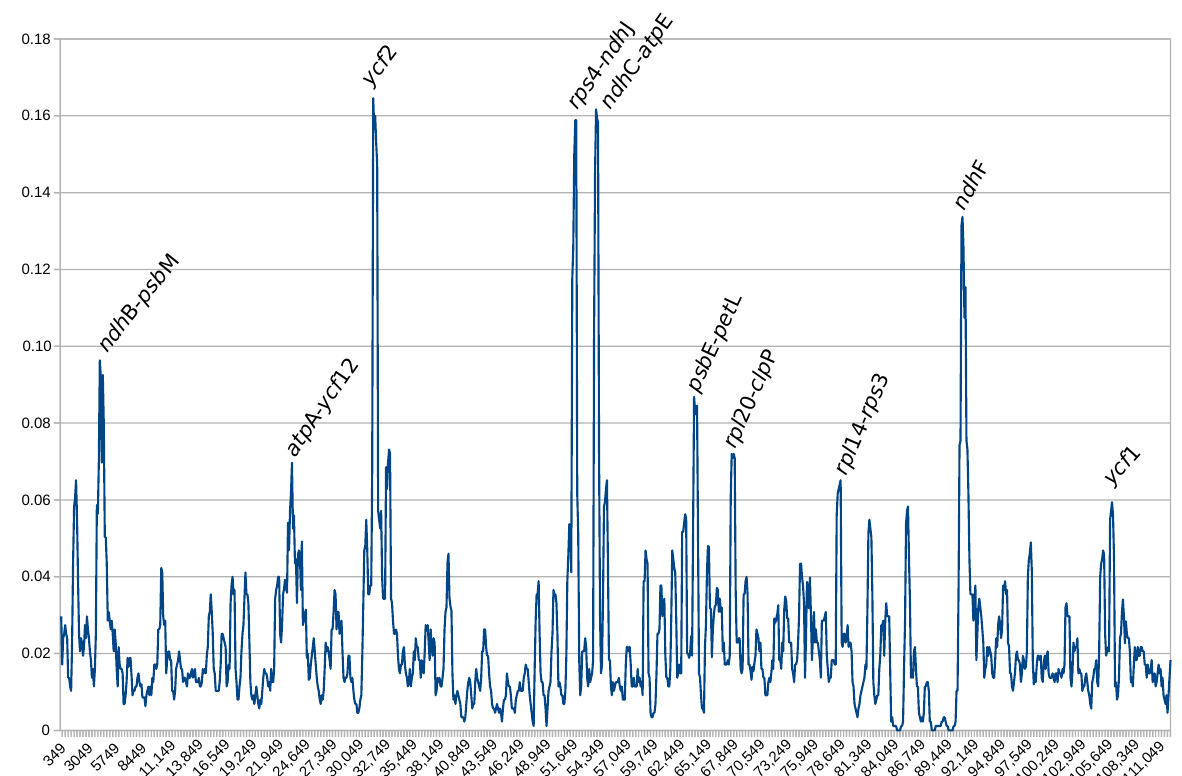
Figure 3. Nucleotide diversity (Pi) by sliding window analysis in the aligned whole plastomes (excluding second IR) of seven Apopellia specimens. Window length 500 bp, step size 100